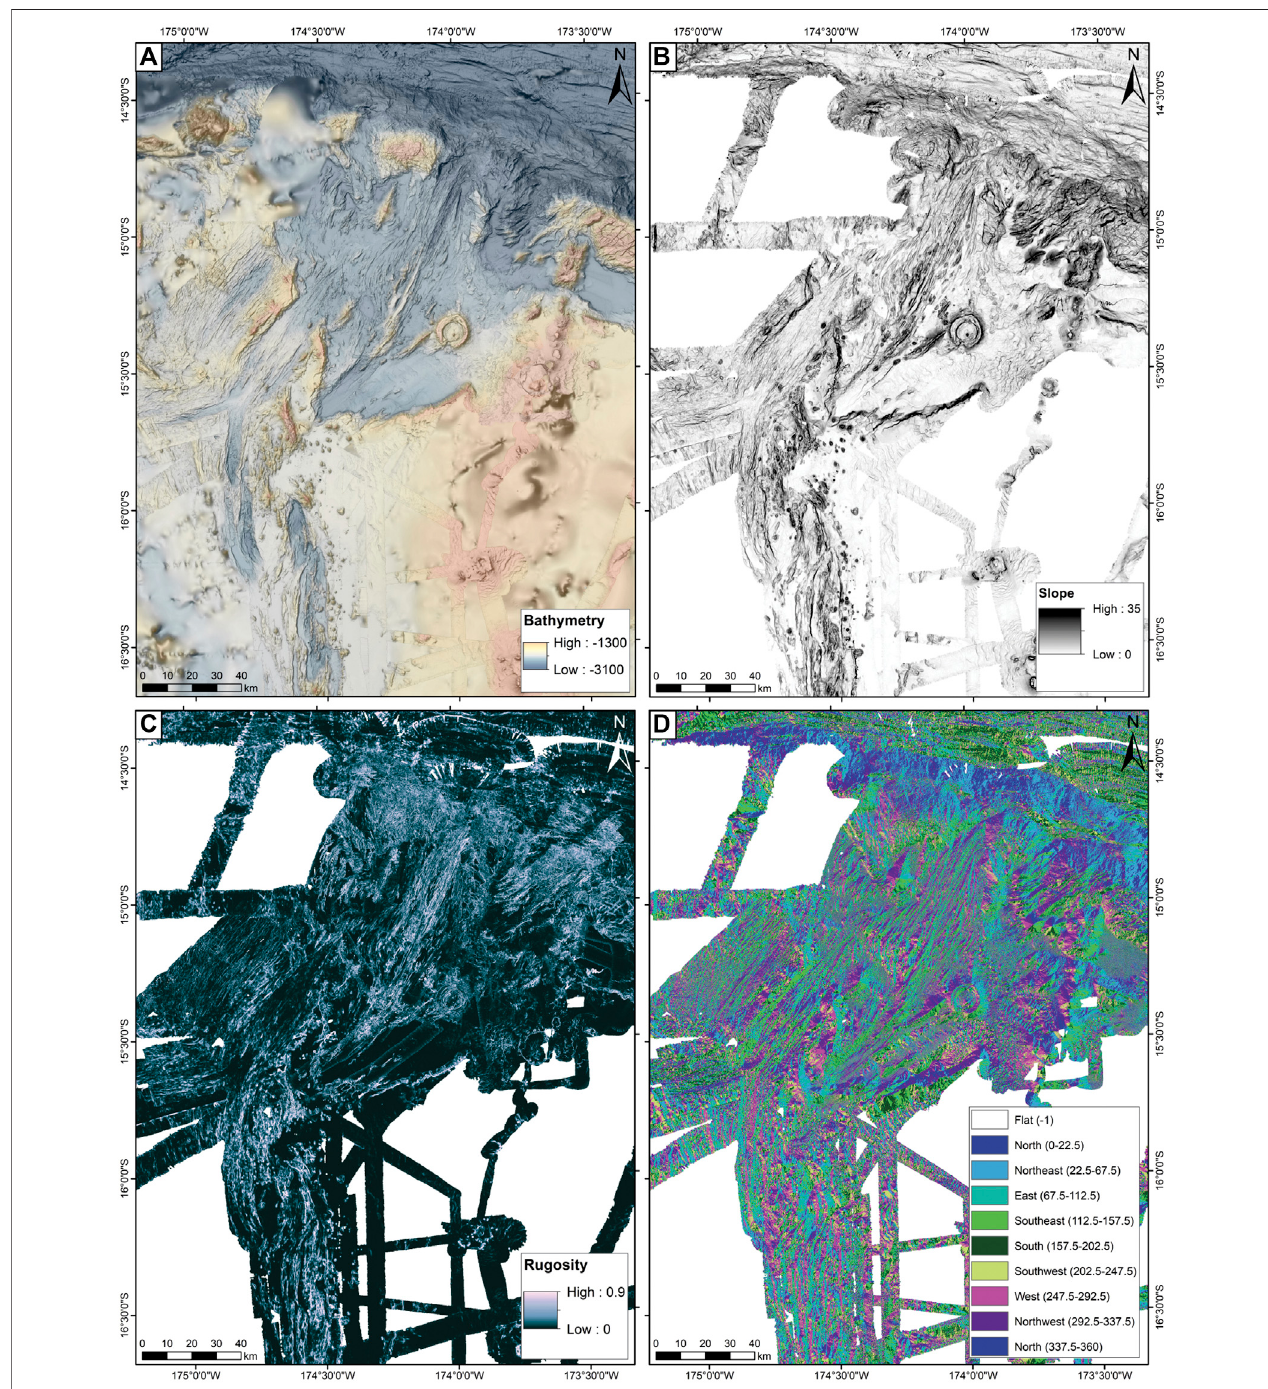
FIGURE 3 | Ship multibeam bathymetry and derived datasets from the NE Lau Basin: (A) ship multibeam bathymetry from Rubin and Shipboard Scienti fi c Party (2010),MartinezandShipboardScienti fi cParty(2013),SleeperandMartinez,(2016),Merleetal.(2018),andHaaseandShipboardScienti fi cParty(2018),overlainonthe GEBCO 2019 regional bathymetric grid (GEBCO Compilation Group, 2019), processed using Terrain Texture Shading (after Brown, 2014); (B) slope of the ship multibeam bathymetry compilation; (C) rugosity (or vector ruggedness measure) of the ship multibeam bathymetry compilation; and (D) aspect of the ship multibeam bathymetry compilation.